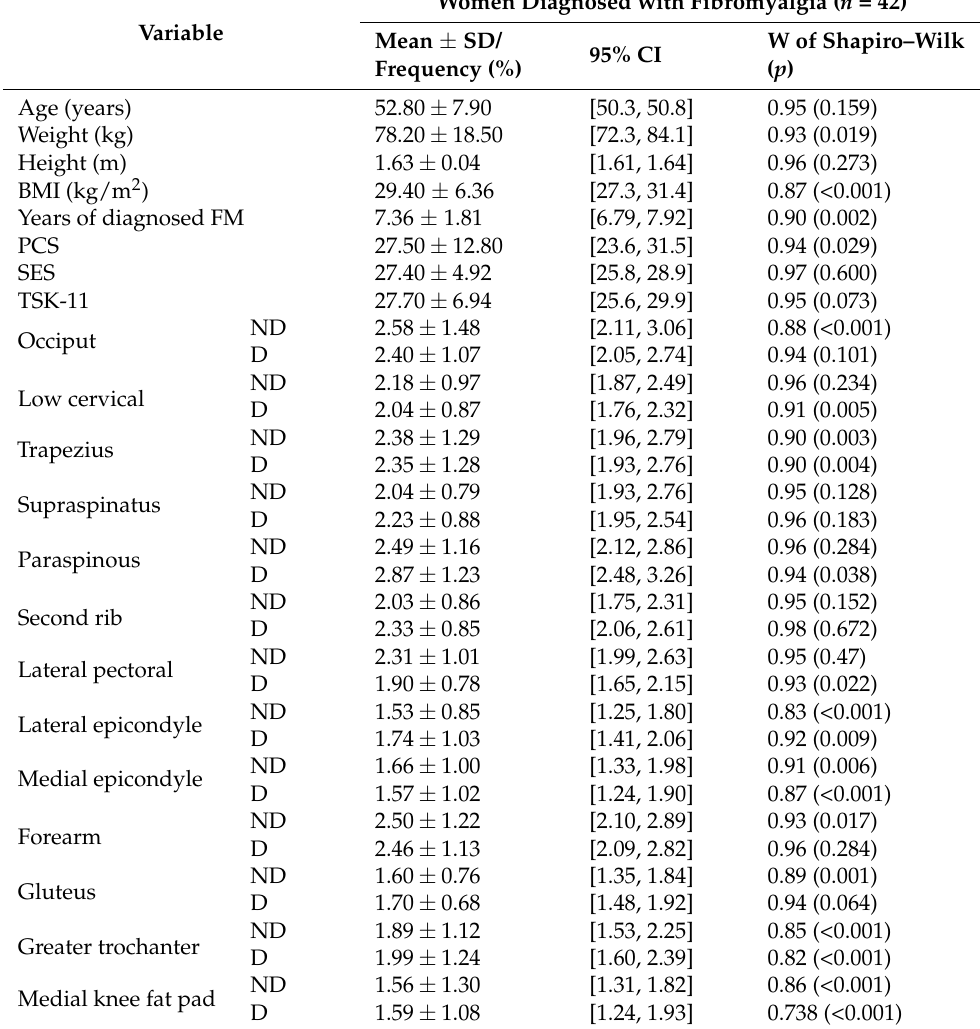
Table 1. Sociodemographic